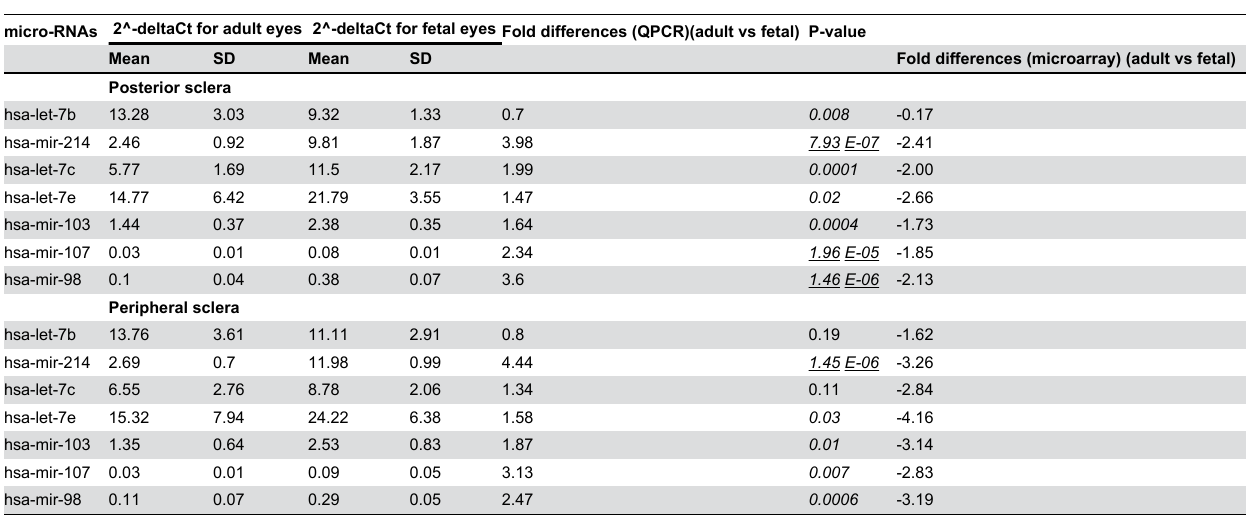
Upregulation in the fetal group is indicated by values greater than 1 for QPCR data, and negative values for microarray data. doi: